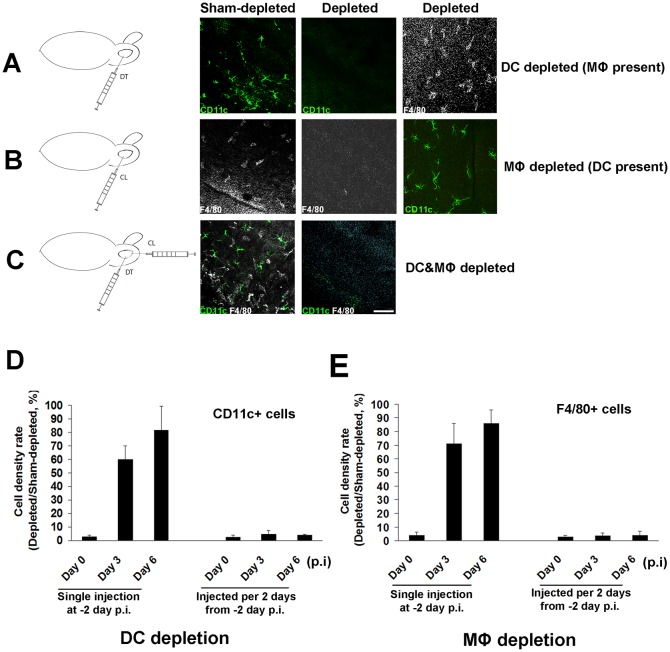
Corneas can be successfully single- or double-depleted of conventional dendritic cells and macrophages.Two days prior to HSV-1 infection (single injection), or every 2 days (multiple injections, started on -2 day p.i.), diphtheria toxin (DT), clodronate liposome (CL) or both, were injected subconjunctivally (s.c.) into CD11c-DTR transgenic or C57BL/6 WT mice in order to deplete corneal cDCs, MΦs or both; C57BL/6 WT mice injected with the mixture of DT and control liposomes (without clodronate) were used as sham-depleted controls. On days 0, 3, 6 p.i., corneas (n = 5/time point) were collected for immunostaining. A: Representative micrographs showing that CD11c+ cells (cDCs) were depleted, but the F4/80+ cells (MΦs) were present after s.c. DT injection. B: MΦs were depleted, but cDCs were present after s.c. CL injection. C: cDCs and MΦs were double-depleted after s.c. injection of DT and CL. D, E: After a single injection of DT on day -2 p.i., cDCs were almost completely depleted on day 0 p.i. However, on day 3 p.i., corneas repopulated with cDCs to 60% of normal corneal levels, and increased to more than 80% on day 6 p.i.; with repeated injections of DT every 2 days, cDCs remained depleted by more than 95% on days 0, 3, 6 p.i. (D). MΦs (E) or cDCs & MΦs (S1C Fig) were similarly depleted with repeated s.c. injections of CL or DT and CL every 2 days. Each experiment was replicated three times. Data are shown as mean ± SD. Scale bar: 100 μm.